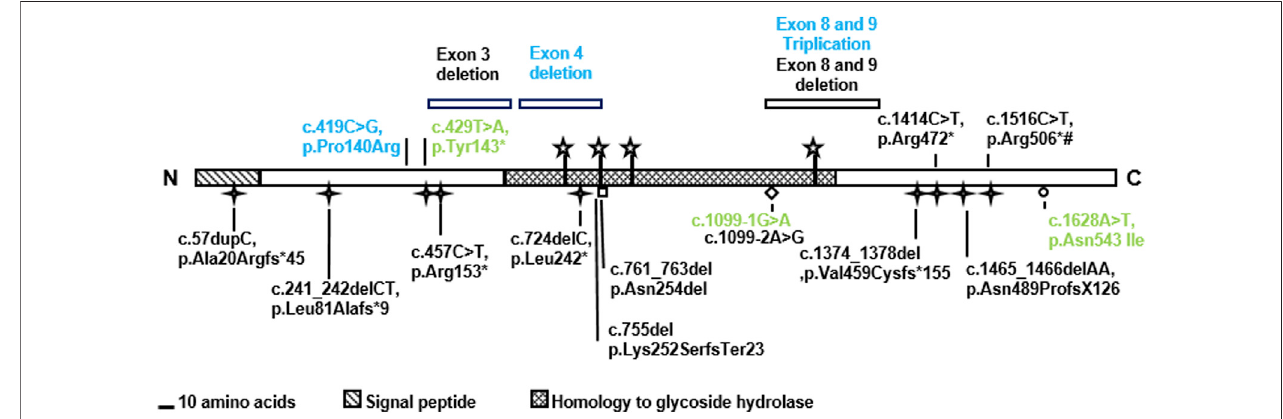
FIGURE 7 | Summary of HPSE2 variants associated with UFS. The novel variants found in the three families in the current report are shown in blue. The variants in green have been reported in previous studies. Two of them were identi fi ed in the affected individuals in this study and the missense variant p.Asn542Ile was considered for its functional consequence. Yet other variants, shown in black, have been reported in previous publications that investigated UFS.